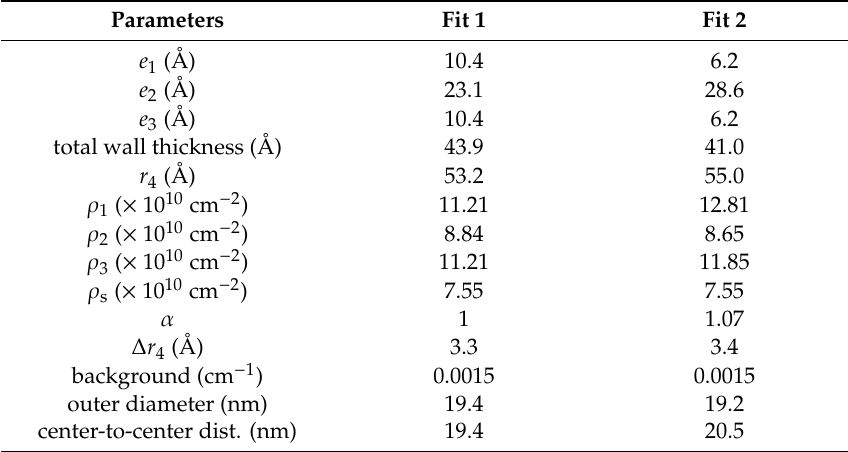
Figure 7. Intensity scattered by HUB-4 (2 wt.% in C 6 H 12 ) and fits with the models of homogeneous tube and with the three-layer model. The parameters of the fits 1 and 2 are given in Table 1.